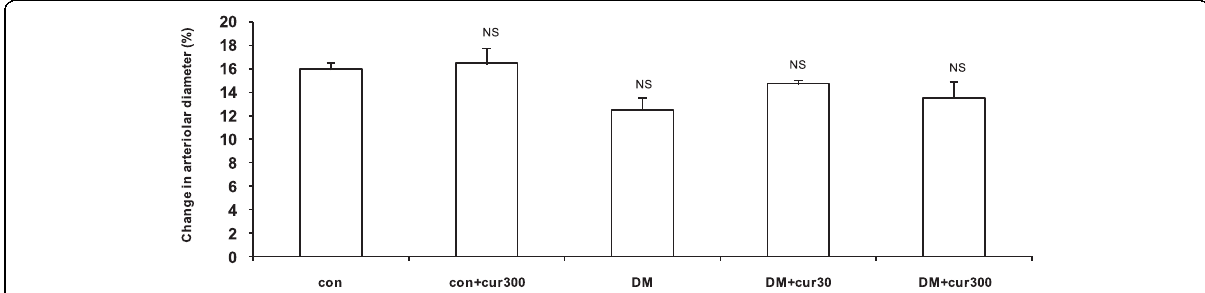
Figure 3 Sodium nitroprusside-induced arteriolar vasodilation . Sodium nitroprusside-induced changes in mesenteric arteriolar diameter from control (con), diabetes (DM) and curcumin-treated groups (con+cur300, DM+cur30, DM+cur300). Data are means ± SEM (n = 5 for each group). NS, no significant difference compared to control arterioles.